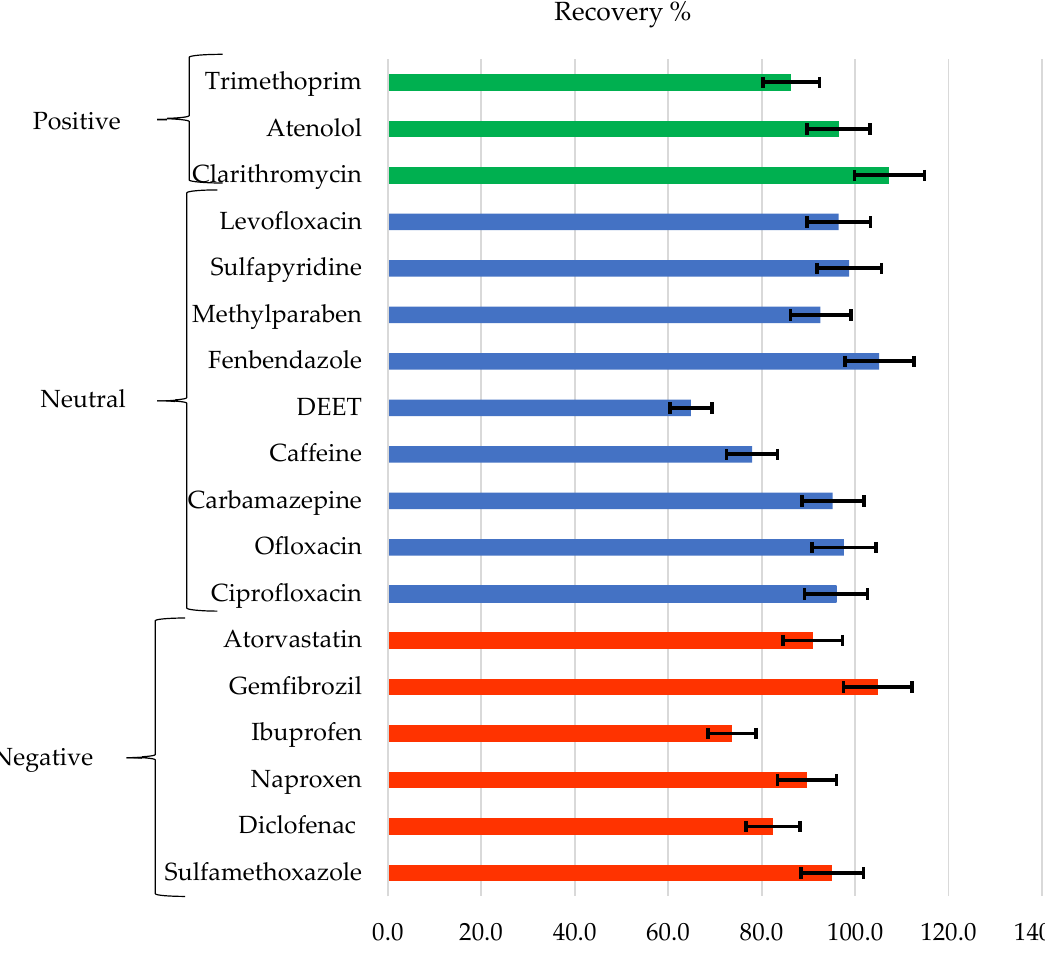
Figure 10. Recovery of contaminants grouped according to their charge at pH = 7.